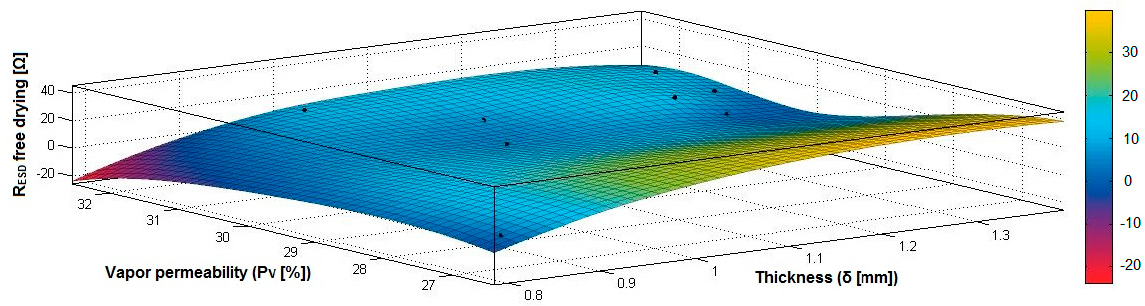
Figure 22. 3D representation R ESD free drying = f(Pv, δ ) for samples preliminarily treated in RF plasma O 2 using RF 1 generator and power 200